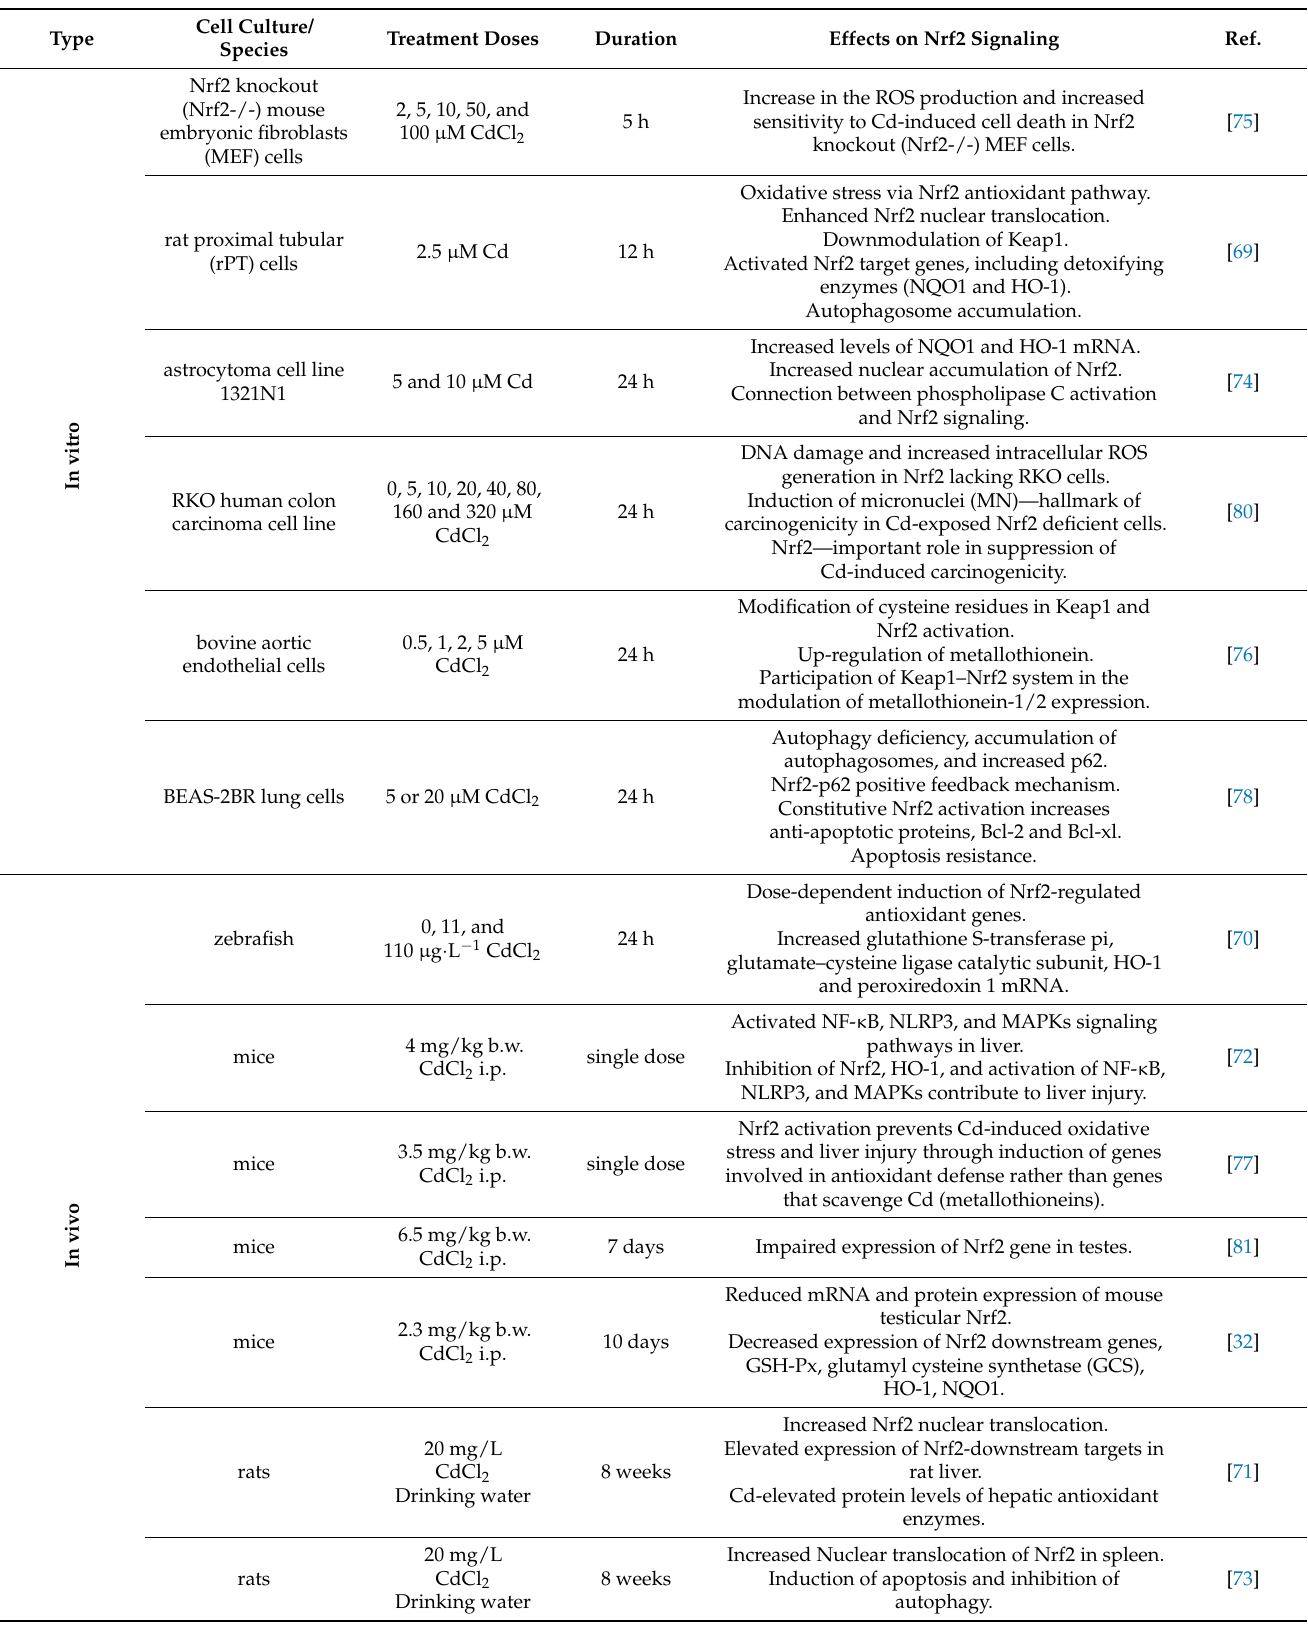
Table 1. Summary of studies analyzing the effects of Cd on Nrf2